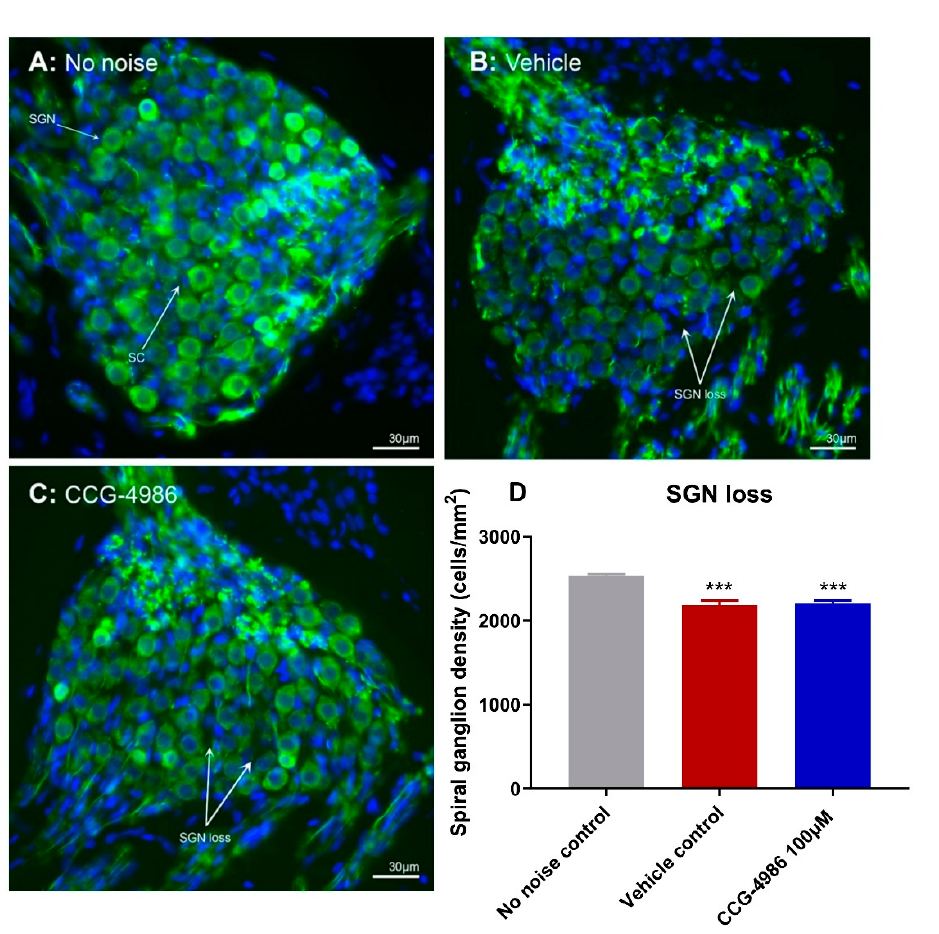
Figure 6. Loss of spiral ganglion neurons (SGN) after noise exposure. ( A – C ) Representative images of Rosenthal’s canal in the middle turn of the cochlea. ( A ) Control non-exposed animals, ( B ) Noise-exposed vehicle-treated, ( C ) Noise exposed CCG-4986 treated. SGN were immunostained with the neurofilament antibody (cytoplasm, green) and Hoescht (nucleus, blue). White arrows point at spaces with missing SGN. Abbreviations: SC, satellite cell; SGN, Spiral ganglion neuron. ( D ) Average SGN densities in the middle turn of the cochlea in noise-exposed vs. non-exposed animals. Data presented as mean ± SEM. No noise control, n = 10; Vehicle control, n = 16; CCG-4986, n = 17. *** p < 0.001; One-way ANOVA followed by Holm–Sidak post hoc test.